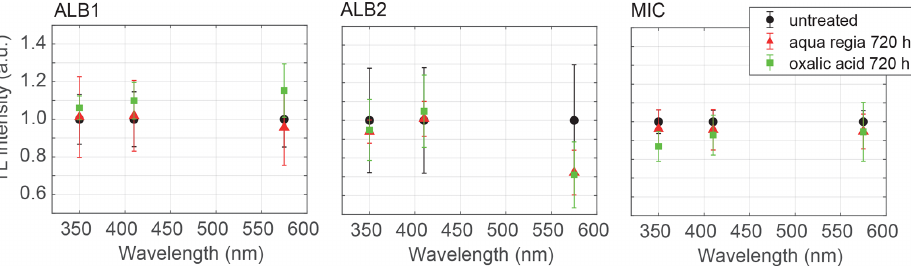
Figure 5. Thermoluminescence (TL) dominant peak positions extracted from TL emission spectra for different wavelengths (near-UV, blue, and green–yellow) for the untreated (black circles) and the chemically treated samples for 720h using aqua regia (red triangles) and oxalic acid (green squares). Aqua regia and oxalic acid spectra were normalised to the untreated sample. All symbols show the mean values measured from three aliquots and associated 1 σ standard deviation. Dominant peak positions: near-UV – 100 ◦ C (MIC) and 250 ◦ C (ALB1,